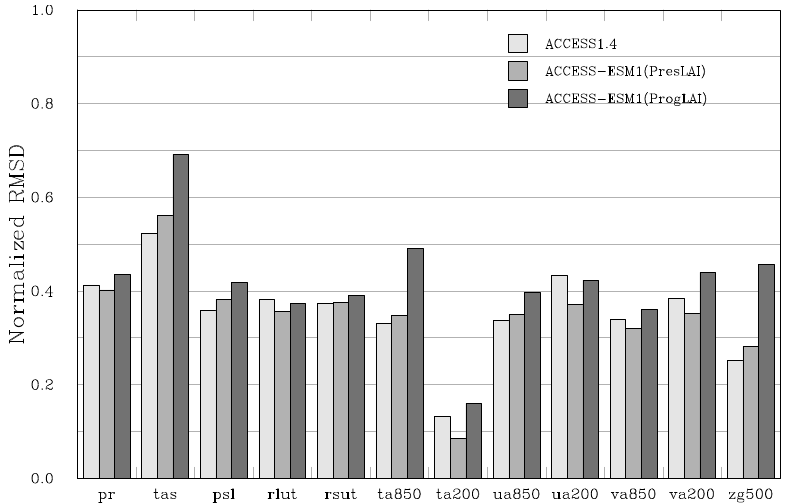
Figure A1. Root mean square difference (RMSD) between atmospheric variables simulated by the model versions listed in the key and those from the ACCESS1.3 pre-industrial simulation normalized by the RMSD between ACCESS1.0 and ACCESS1.3. The variables are precipitation (pr), surface air temperature (tas), sea level pressure (psl), top of atmosphere long-wave radiation (rlut), top of atmosphere reflected short-wave radiation (rsut), air temperature (ta), zonal (ua) and meridional wind (va) at 850 and 200hPa and geopotential height (zg) at